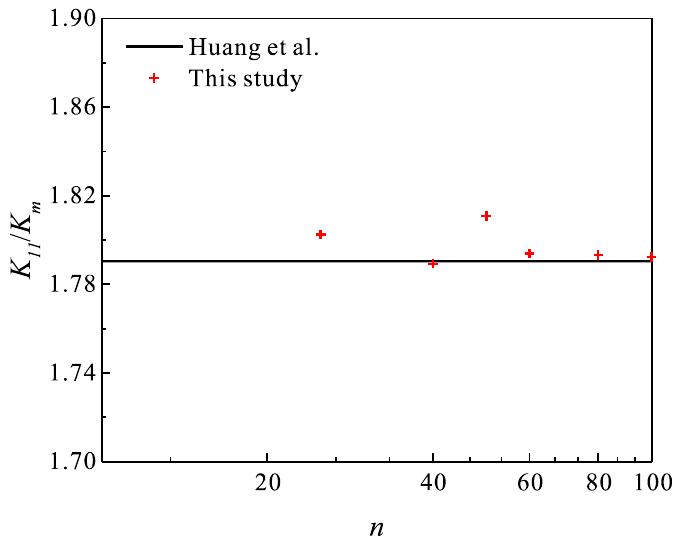
estimation of upscaled permeability and thus examines its validity. The difference between boundary cannot be precisely represented by our discretization scheme. This is partially more computation time. To compromise between these two effects, we choose n = 50 in the remainder of this study.